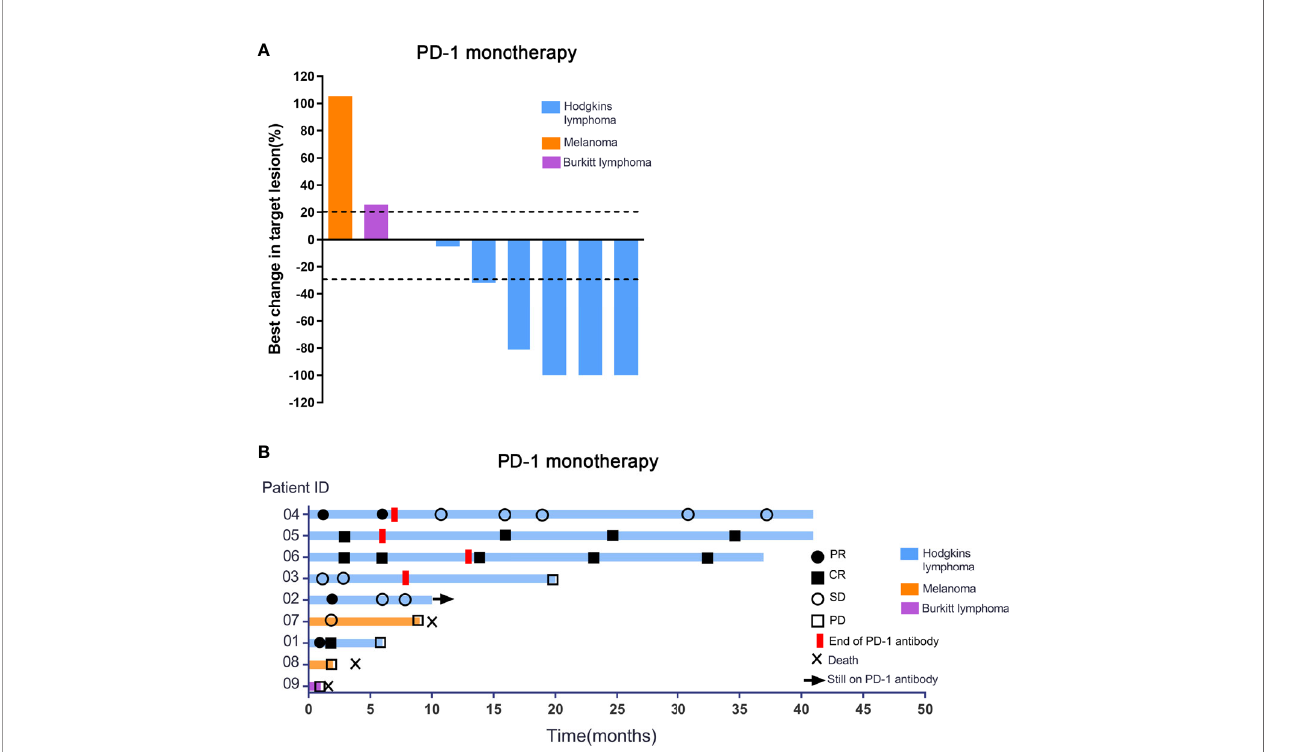
FIGURE 1 | Response characteristics and changes in tumor burden in patients receiving PD-1 inhibitor alone. (A) Shown are best percentage changes from baseline in the sum of the longest diameter of target lesions in patients treated with PD-1 monotherapy with at least one post-baseline assessment. (B) Swimmer ’ s Plot of Time on Treatment for 9 evaluable Patients treated with PD-1 monotherapy. As shown in Figure 1 , no objective response was observed in patients with melanoma or Burkitt lymphoma evaluated in this study. Stable disease was reported as the best response in patient 7. This patient had metastatic disease at the time of enrollment and had progressed despite two palliative surgical resections. After anti-PD-1 treatment, he achieved progression free survival for 9 months. Patient 8 progressed after treatment with 2 cycles of PD-1 antibody and the PFS was 62 days. Patient 9 achieved only 1 cycle of PD-1 antibody and progressed rapidly. Patient #7, 8 and 9 patients had eventually died due to tumor